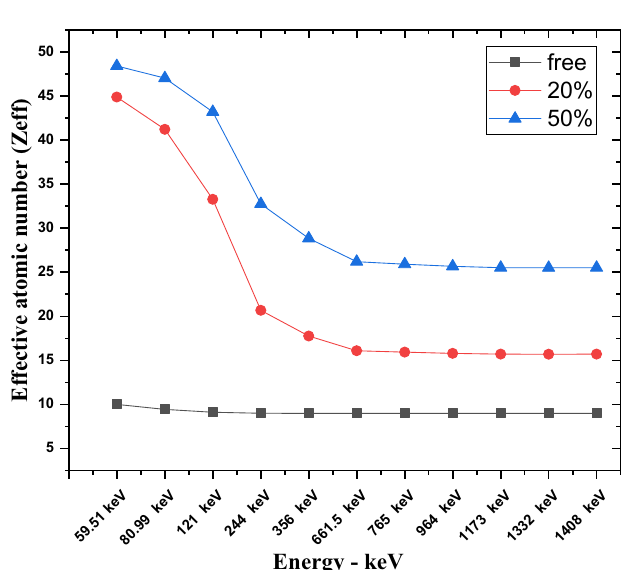
Figure 10. ( a ) Radiation protection efficiency at different energies at 1 cm, ( b ) Mean free path of free silicon rubber and different weight fraction of SnO 2 /SR at different energies.